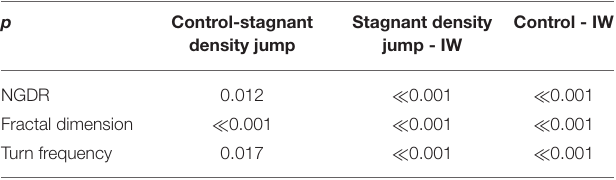
TABLE 1 | Tukey–Kramer post-hoc test results for NGDR, fractal dimension, and turn frequency between pairs of treatments based on α = 0.05. p Control-stagnant density